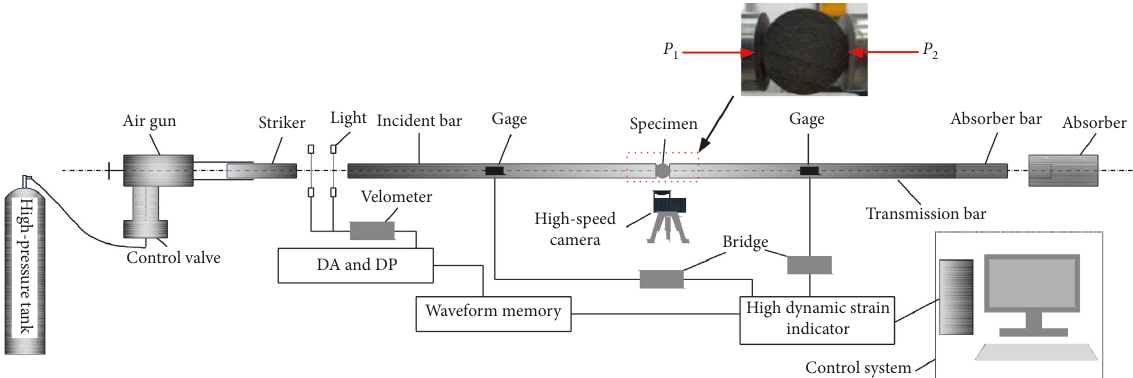
Figure 2: Dynamic Brazilian disc test in the split Hopkinson pressure bar